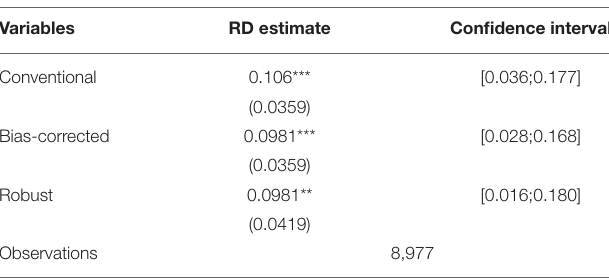
TABLE 4 | Point estimation results for Figure 3